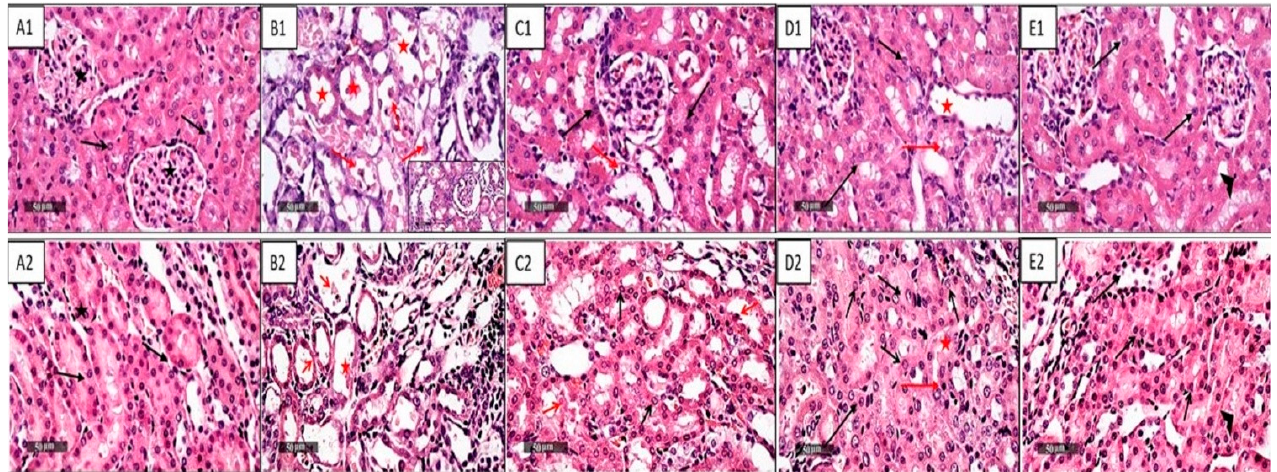
Figure 1. Histological Photomicrographs of the Kidney Specimens from Different Treatment Groups Stained with H and E. ( A1 , A2 ): Control group shows normal histological structure of the kidney glomeruli and renal tubules with the outer medullary region ( A2 ); ( B1 , B2 ): Cisplatin-injected group shows severe tubular degenerative changes with cystic dilations and necrotic tubular segments of proximal and distal tubules (red star) and necrotic epithelial cells (red arrow) with mild interstitial inflammatory cells infiltrates; ( C1 , C2 ): NAC group (250 mg/kg/day p.o.) shows almost intact renal parenchyma and tubular epithelium (black arrow) with few focal records of degenerated tubular cells and pyknotic nuclei (red arrow); ( D1 , D2 ): CGA group (20 mg/kg/day p.o.) appears almost intact renal parenchyma and tubular epithelium (black arrow) with minimal records of dilated (red star) or degenerated tubular segments (red arrow), and minimal inflammatory cells infiltrate; ( E1 , E2 ): Combined group (NAC and CGA) shows apparent intact renal parenchyma and tubular epithelium (black arrow) with minimal dilatation of a few tubular segments, as well as occasional periglomerular inflammatory cells infiltrates (arrowhead), 400 × . NAC: N-acetylcysteine; CGA: Chlorogenic acid. On the other hand, the injection of Cp shows diffuse records of severe tubular degen- erative changes at corticomedullary junctions with abundant figures of cystic dilations and necrotic tubular segments in both proximal and distal tubules (red star), with moderate forms of intraluminal desquamated necrotic epithelial cells (red arrow) with mild intersti- tial inflammatory cells infiltrates (Figure 1(B1,B2)). Meanwhile, the administration of NAC shows almost intact morphological features of renal parenchyma and tubular epithelium (black arrow) with few focal records of degenerated tubular cells with pyknotic nuclei (red arrow) (Figure 1(C1,C2)). In contrast, the CGA group demonstrates almost intact morphological features of renal parenchyma and tubular epithelium (black arrow) with minimal records of dilated (red star) or degenerated tubular segments (red arrow), as well as minimal inflammatory cells infiltrate (Figure 1(D1,D2)). Moreover, a combined group of both NAC and CGA shows apparent intact renal parenchyma and tubular epithelium (black arrow) with minimal dilatation of a few tubular segments, as well as occasional periglomerular inflammatory cells infiltrates (arrowhead) (Figure 1(E1,E2)). The scoring of renal tissue damage was represented in Table 2. Collectively, these results indicate that NAC and CGA alleviates Cp-induced